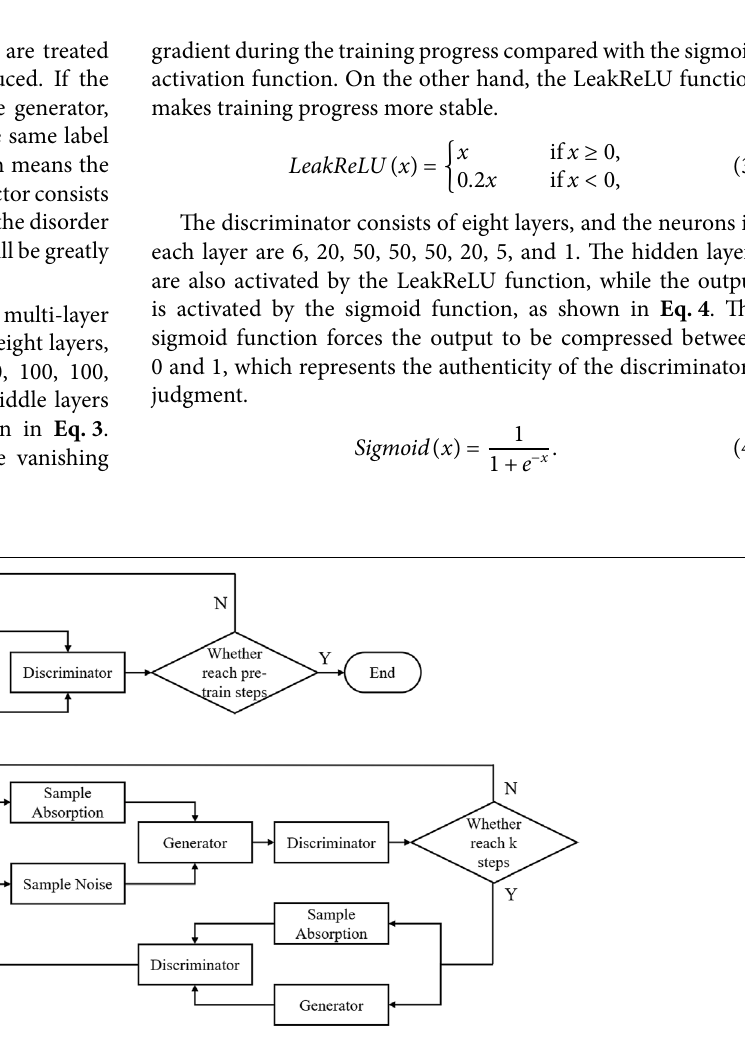
Frontiers in Materials |